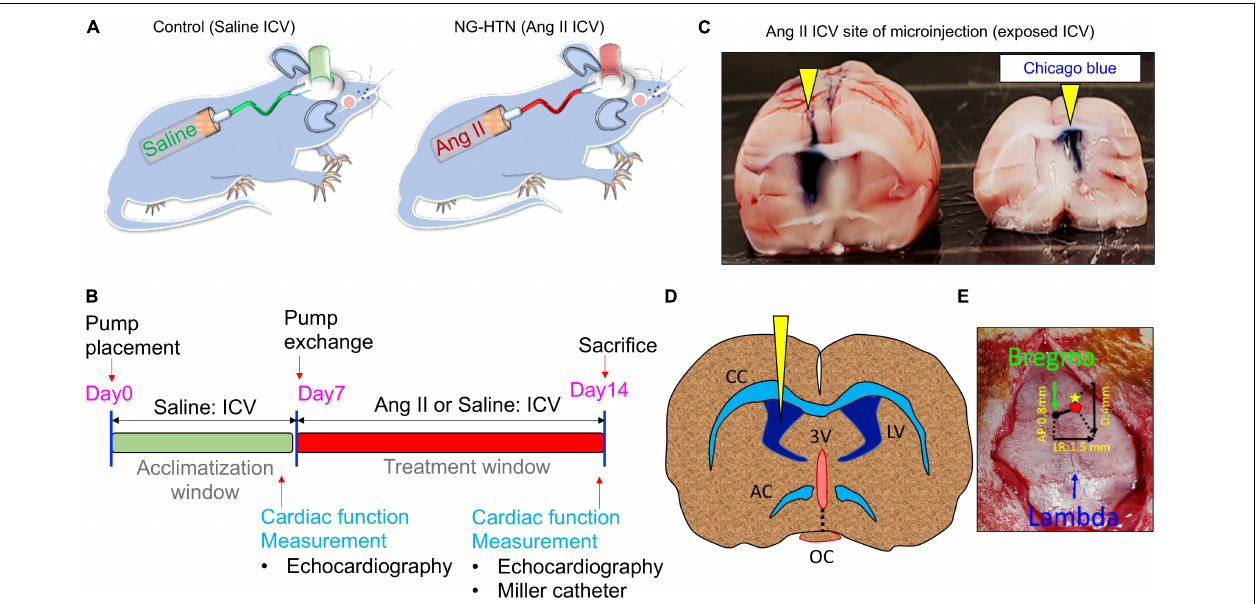
FIGURE 1 | Schematic showing chronic Ang II intracerebroventricular (ICV) infusion timeline and protocol to develop NG-HTN. (A) Schematic showing development of rat model of neurogenic hypertension via ICV Ang II brain minipump infusion. Sprague-Dawley rats (250–300 g) subjected to ICV Ang II brain minipump infusion (20 ng/min, 14 days, 0.5 µ l/h) or vehicle (control, 0.9% sterile saline infusion) through osmotic mini-pumps. (B) Schematic timeline of treatment and cardiac function measurements. (C) Representative whole brain image showing exposed ICV cannulation site of Ang II or saline infusion confirmed by Chicago blue dye flushing through the cannulation tube at the time of sacrifice (yellow arrowheads). (D) Schematic coronal brain slice shown for ICV cannulation. (E) Stereotactic co-ordinate measurements of brain cannulation and ICV pump implantation, AP, LR, and D co-ordinate measurement are shown with a referenced from the